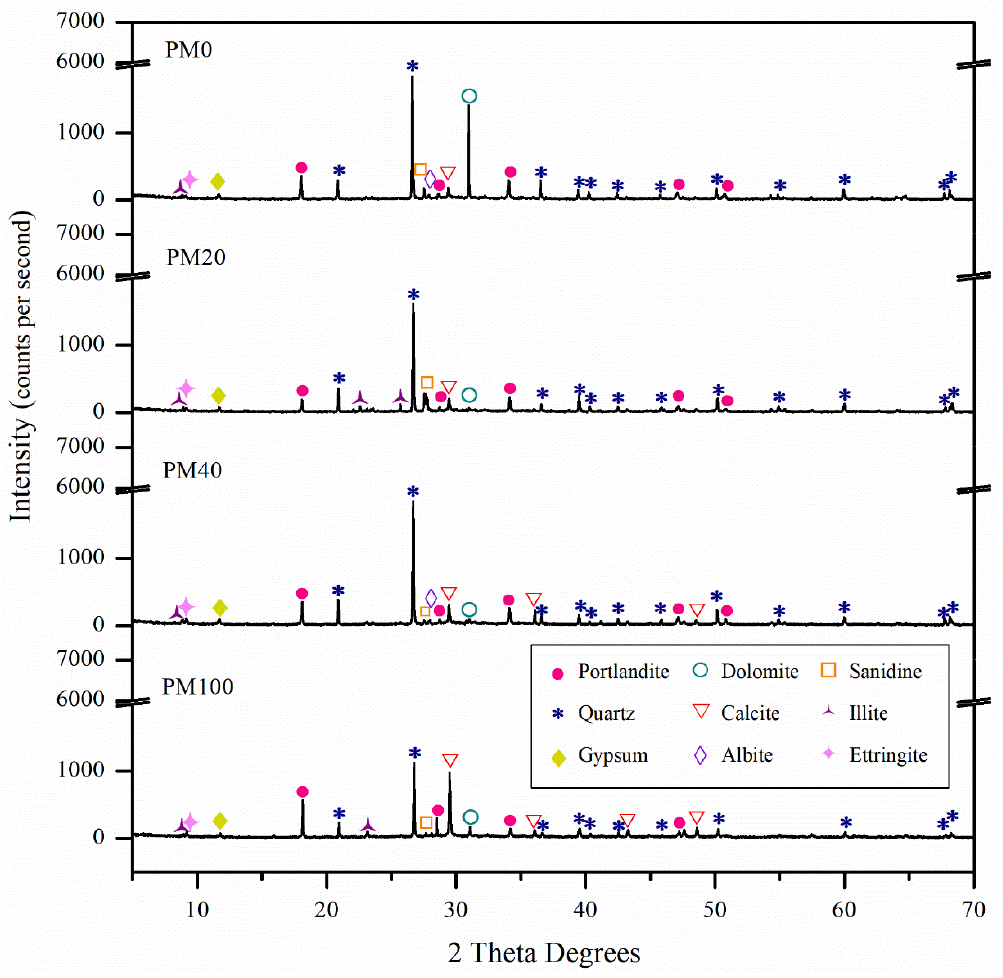
Figure 4. X-ray di ff raction patterns of photocatalytic mortar family. Figure 4. X-ray diffraction patterns of photocatalytic mortar family.